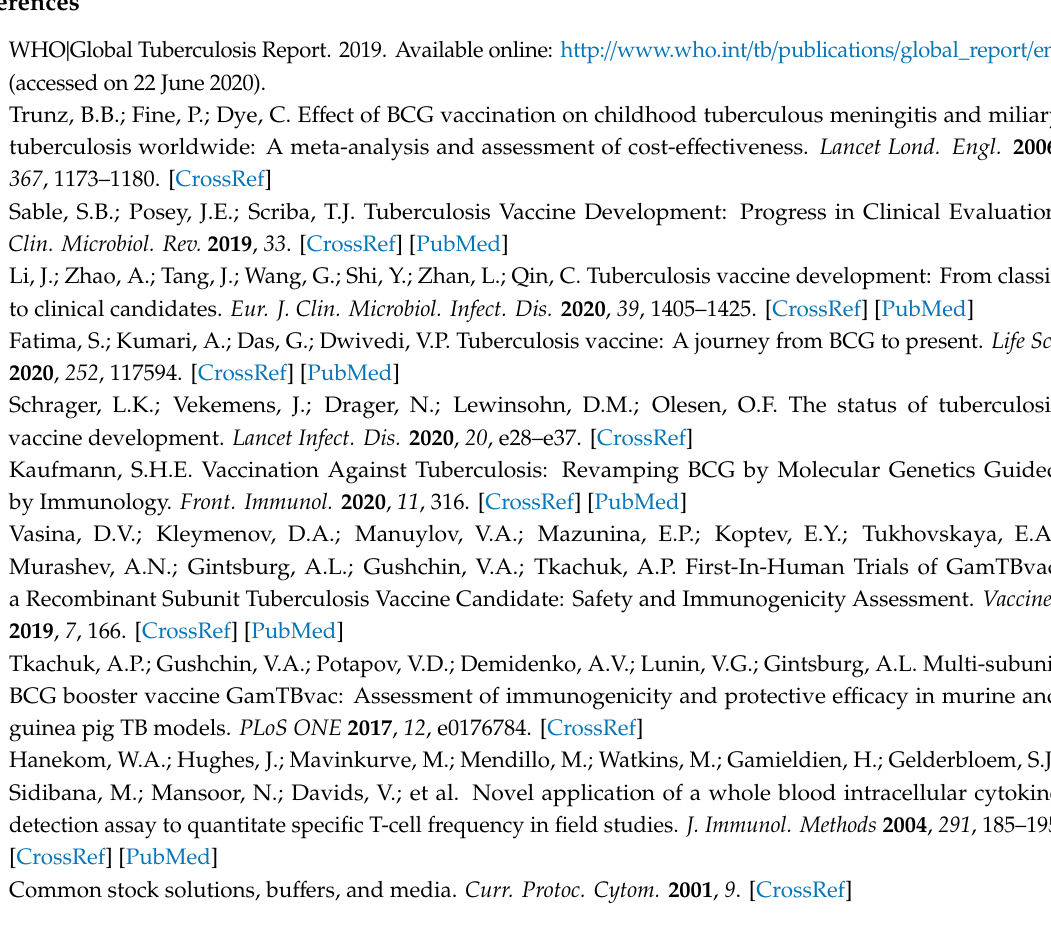
Table S1. Inclusion, non-inclusion, and exclusion criteria; Table S2. Demographic characteristics of enrolled participants who received at least one dose of the study drug and had at least one immunogenicity evaluation; Table S3: Total adverse events, safety evaluation set, n = 180; Table S4. Percentages of volunteers with positive specific IgG responses to immunization with GamTBvac; Figure S1. Study design and procedures; Figure S2. CONSORT diagram of study flow: Figure S3. CD4 + T-cell responses after stimulation with both fusions of